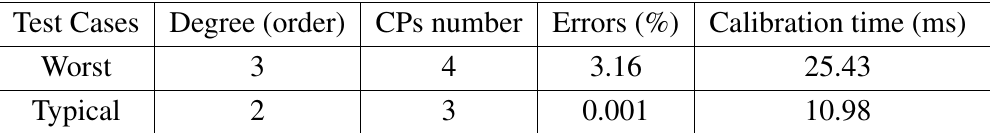
Table 2. Performance results of SSCP.